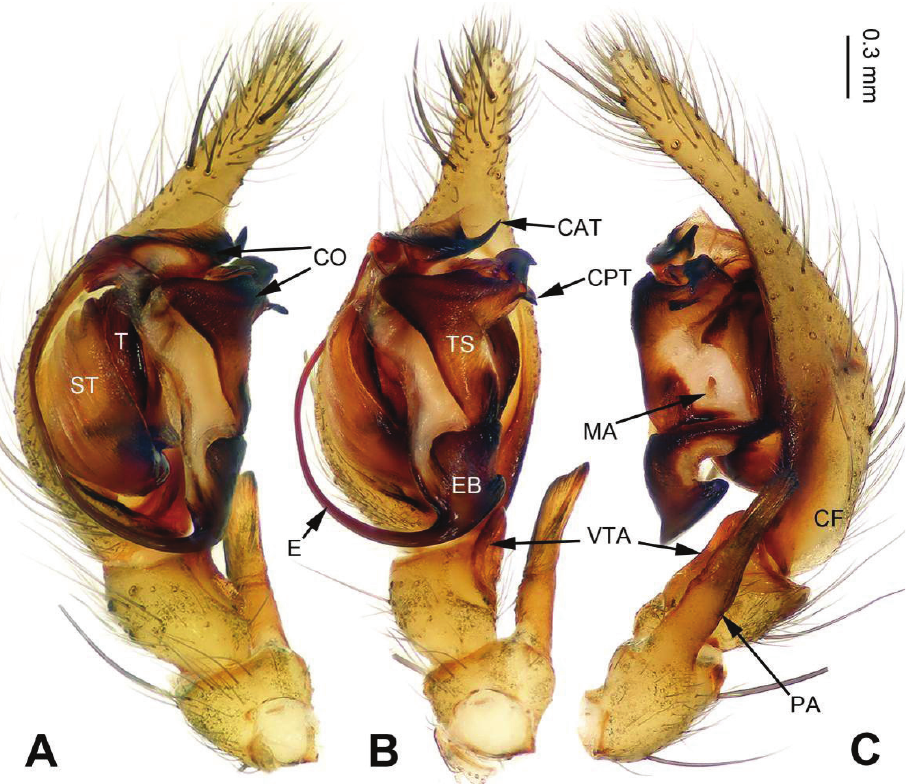
Figure 1. Palp of Longicoelotes geei sp. n., holotype male. A Prolateral view B Ventral view C Retrolateral view. CAT = anterior tip of conductor, CF = cymbial furrow, CO = conductor, CPT = posterior tip of conductor, E = embolus, EB = embolic base, MA = median apophysis, PA = patellar apophysis, ST = sub- tegulum, T = tegulum, TS = tegular sclerite, VTA = ventral tibial apophysis. Scale bar: equal for A, B, C . bium; cymbial furrow long, about 1/3 length of cymbium; ventral tibial apophysis as long as tibia, without pointed tip, extending beyond the tibia; conductor slender and bifurcated; posterior tip of conductor bifurcated; anterior tip of conductor bifur- cated, ventral part sharp, dorsal part lamellate; median apophysis reduced; embolus beginning at 5:30 o’clock